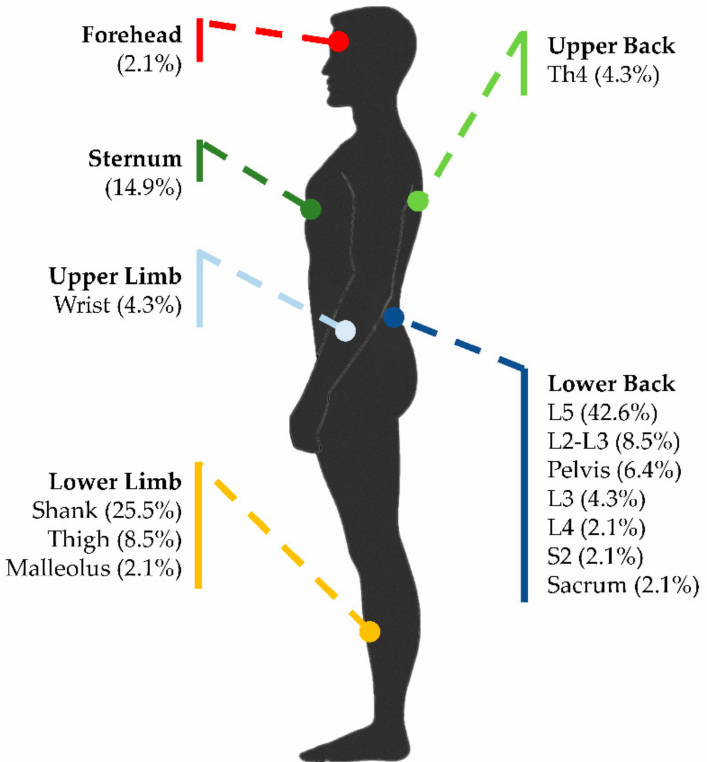
Figure 2. Sensor placements reported in experimental protocols with indication of the percentage of the articles included in this review that consider each